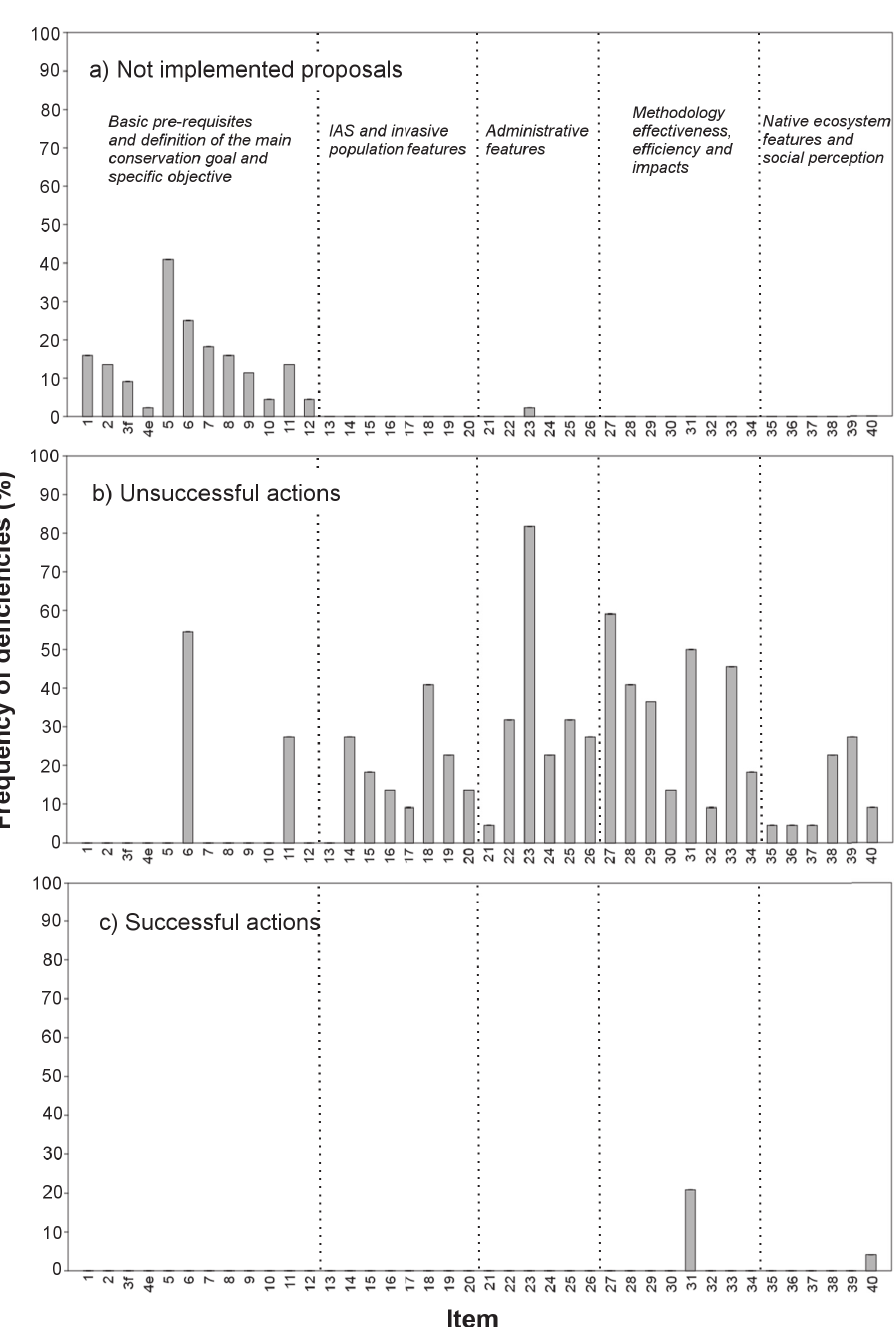
Figure 2. Percentage of deficiencies for the different checklist items (see Suppl. material 1: Table S1) in a not-implemented ( n = 44) b unsuccessful ( n = 22), and c successful ( n = 24) actions aimed at managing IAS in Andalusia in 2004–2018. See Table 1 for a description of each